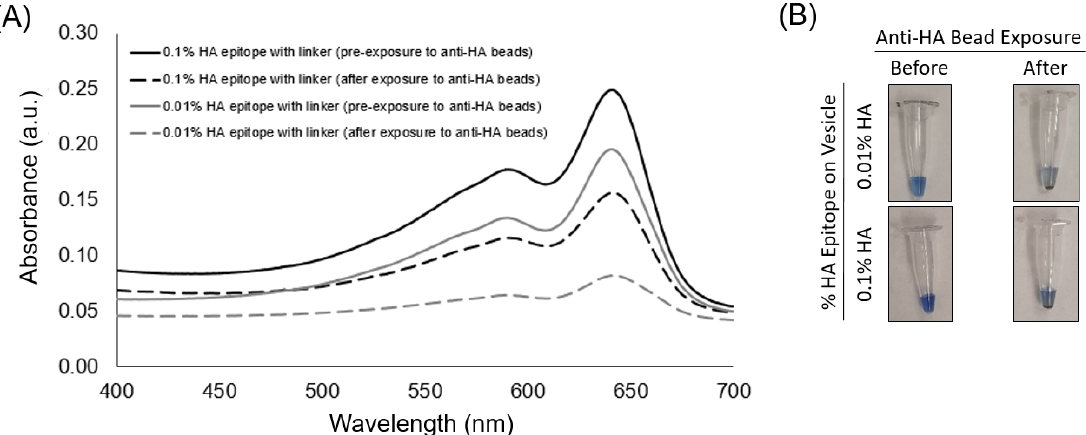
Figure 3. ( A ) Spectra and ( B ) images comparing vesicles with 0.1% or 0.01% HA epitope-labeled amphiphiles in terms of their ability to be bound and captured by anti-HA antibodies linked to magnetic beads.